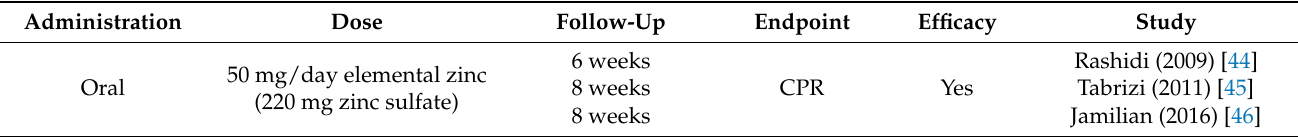
Table 8. Dose finding according to single trial results for